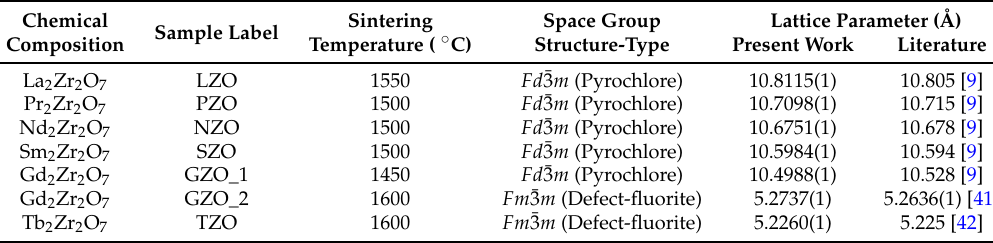
Table 3. Summary of the conditions used for the preparation of the A 2 Zr 2 O 7 feed rods. Two samples of Gd 2 Zr 2 O 7 composition were prepared at the different temperatures given below. All the polycrystalline materials were sintered for a duration of 48 to 96 h. The crystal phase of each sample is given, with the corresponding lattice